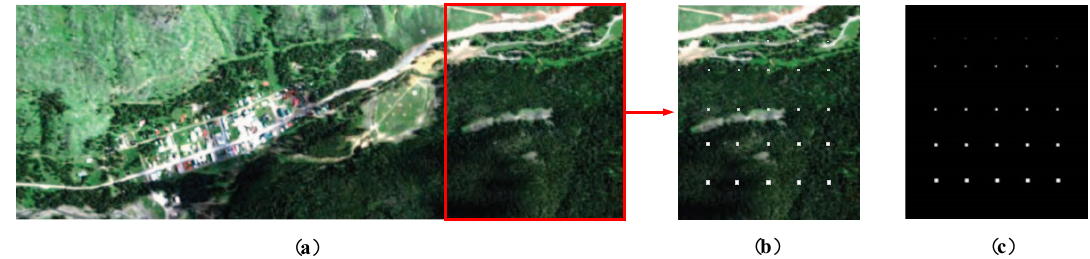
Figure 4. Dataset of synthetic targets for experiment. ( a ) False color image of the whole scene; ( b ) false color image of the detection area; ( c ) ground-truth of simulated dataset.